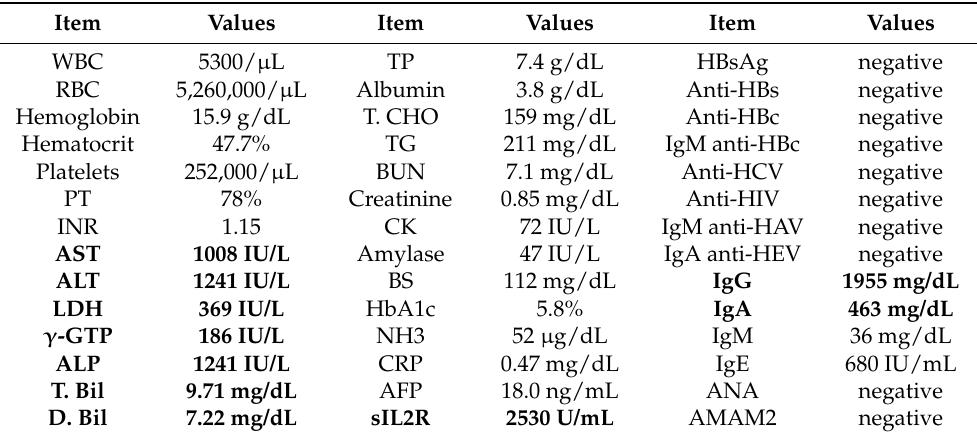
Table 1. The laboratory data on admission in the present case.